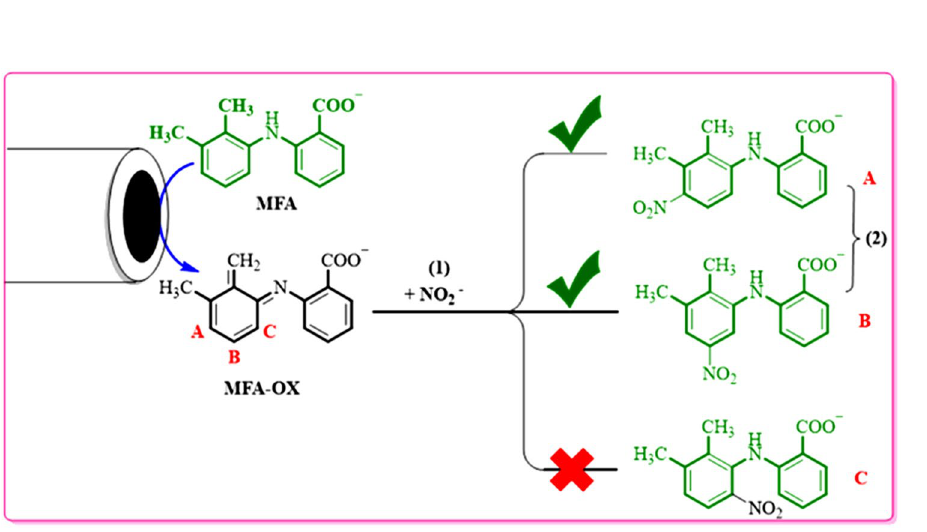
Figure 12. Different pathways of nucleophilic addition reaction of